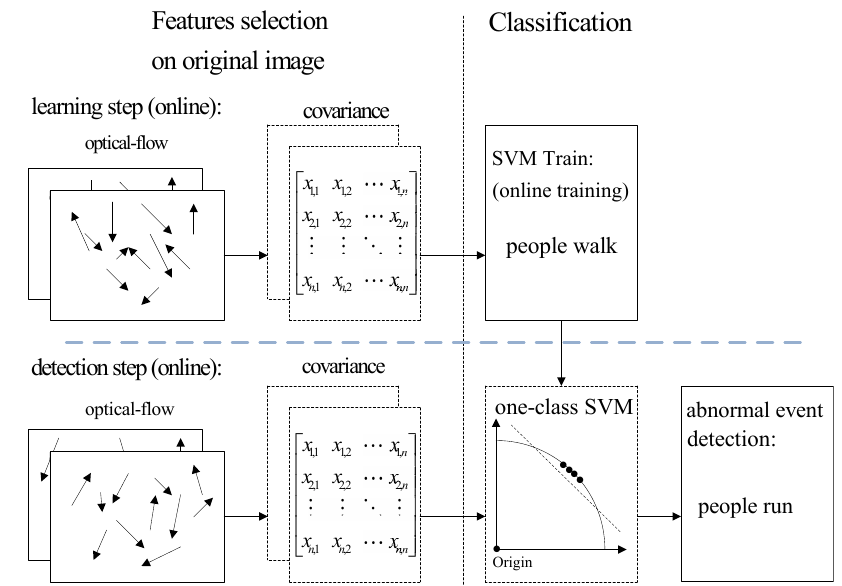
Figure 3. Major processing states of the proposed abnormal frame event detection method. The covariance of the frame is